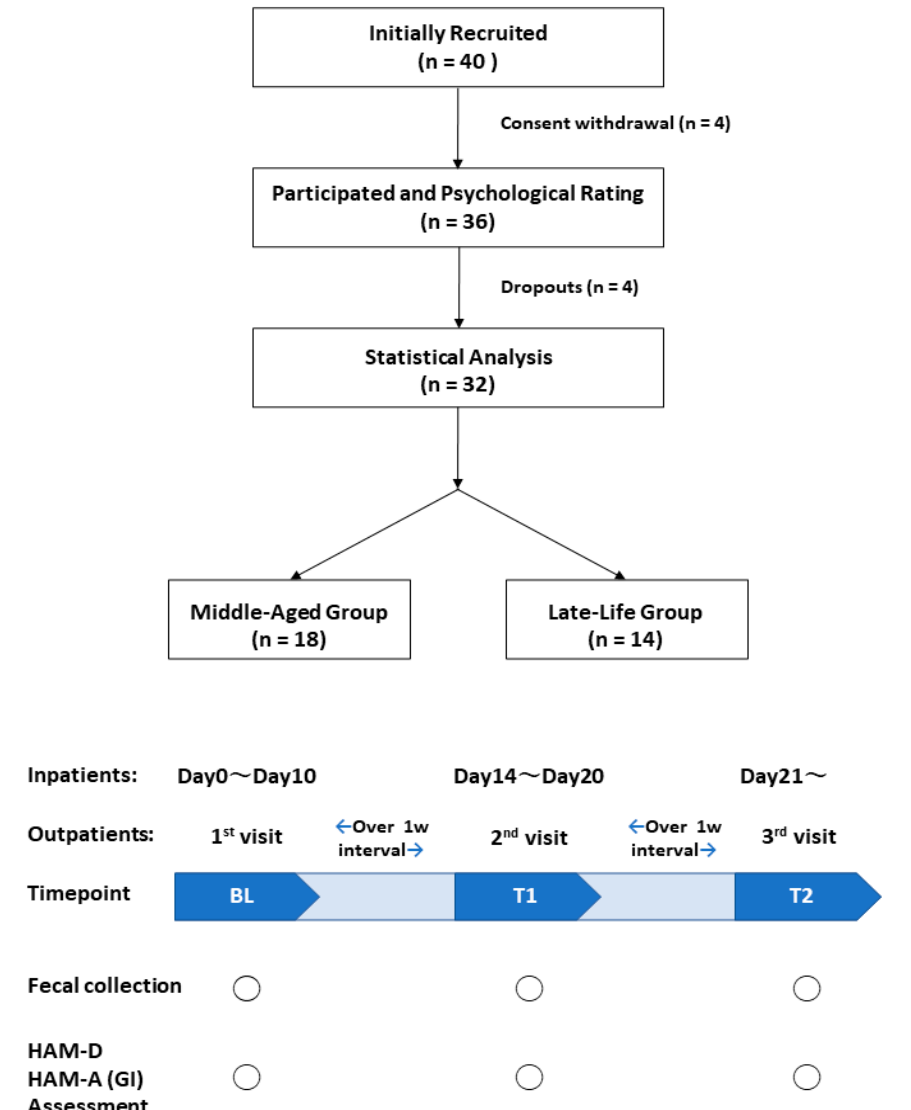
Figure 1. Flow chart of participants through the trial. BL, baseline assessments; T1, midterm assessments; T2, endpoint assessments; HAM-D, Hamilton Depression Scale; HAM-A, Hamilton Anxiety Scale; GI, gastrointestinal .